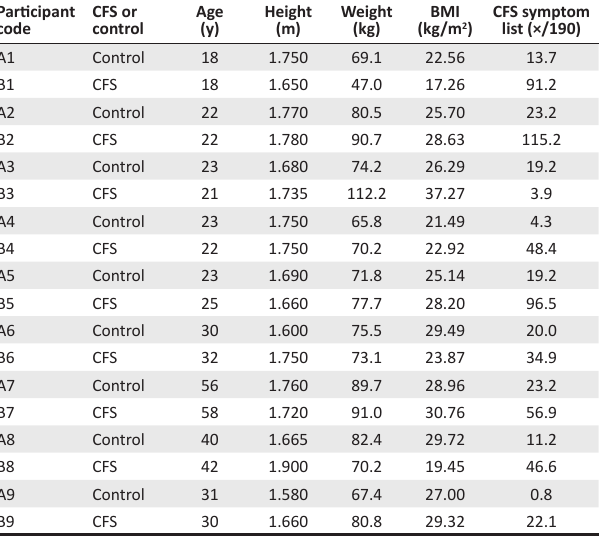
TABLE 1: Participant characteristics. Participant code